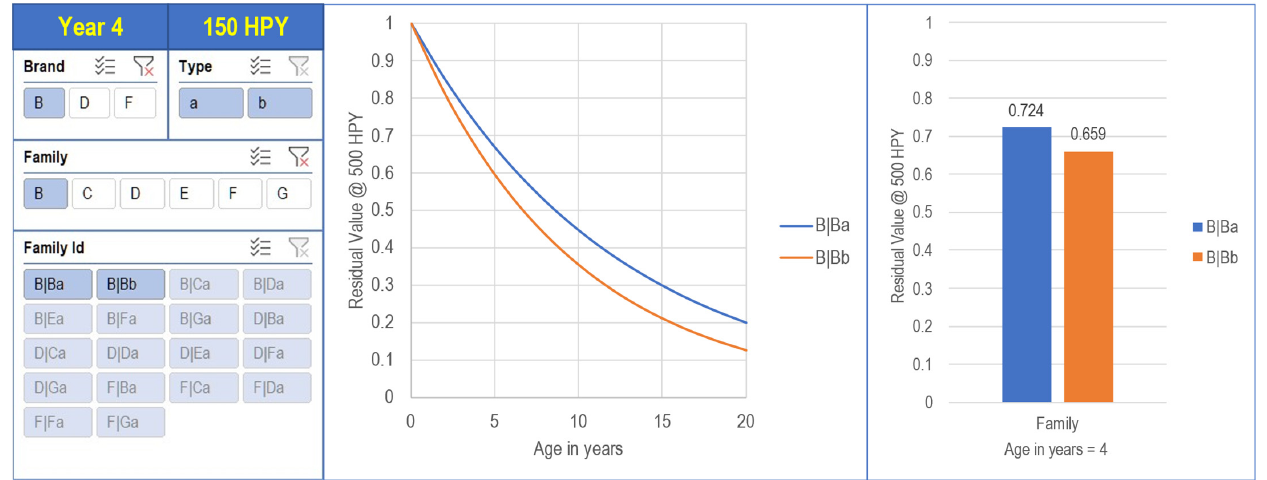
Figure 11. Residual value (value as new =1) comparison of Brand B high performance combine fam- ilies B|Ba featuring tires and B|Bb featuring rubber tracks with 150 h per year (HPY). Not all combines are created equal, and neither are their performance capacities nor the cost of operation. The proposed power residual value regression clearly states that the cost of ownership is also not created equal, showing signi fi cant di ff erences.